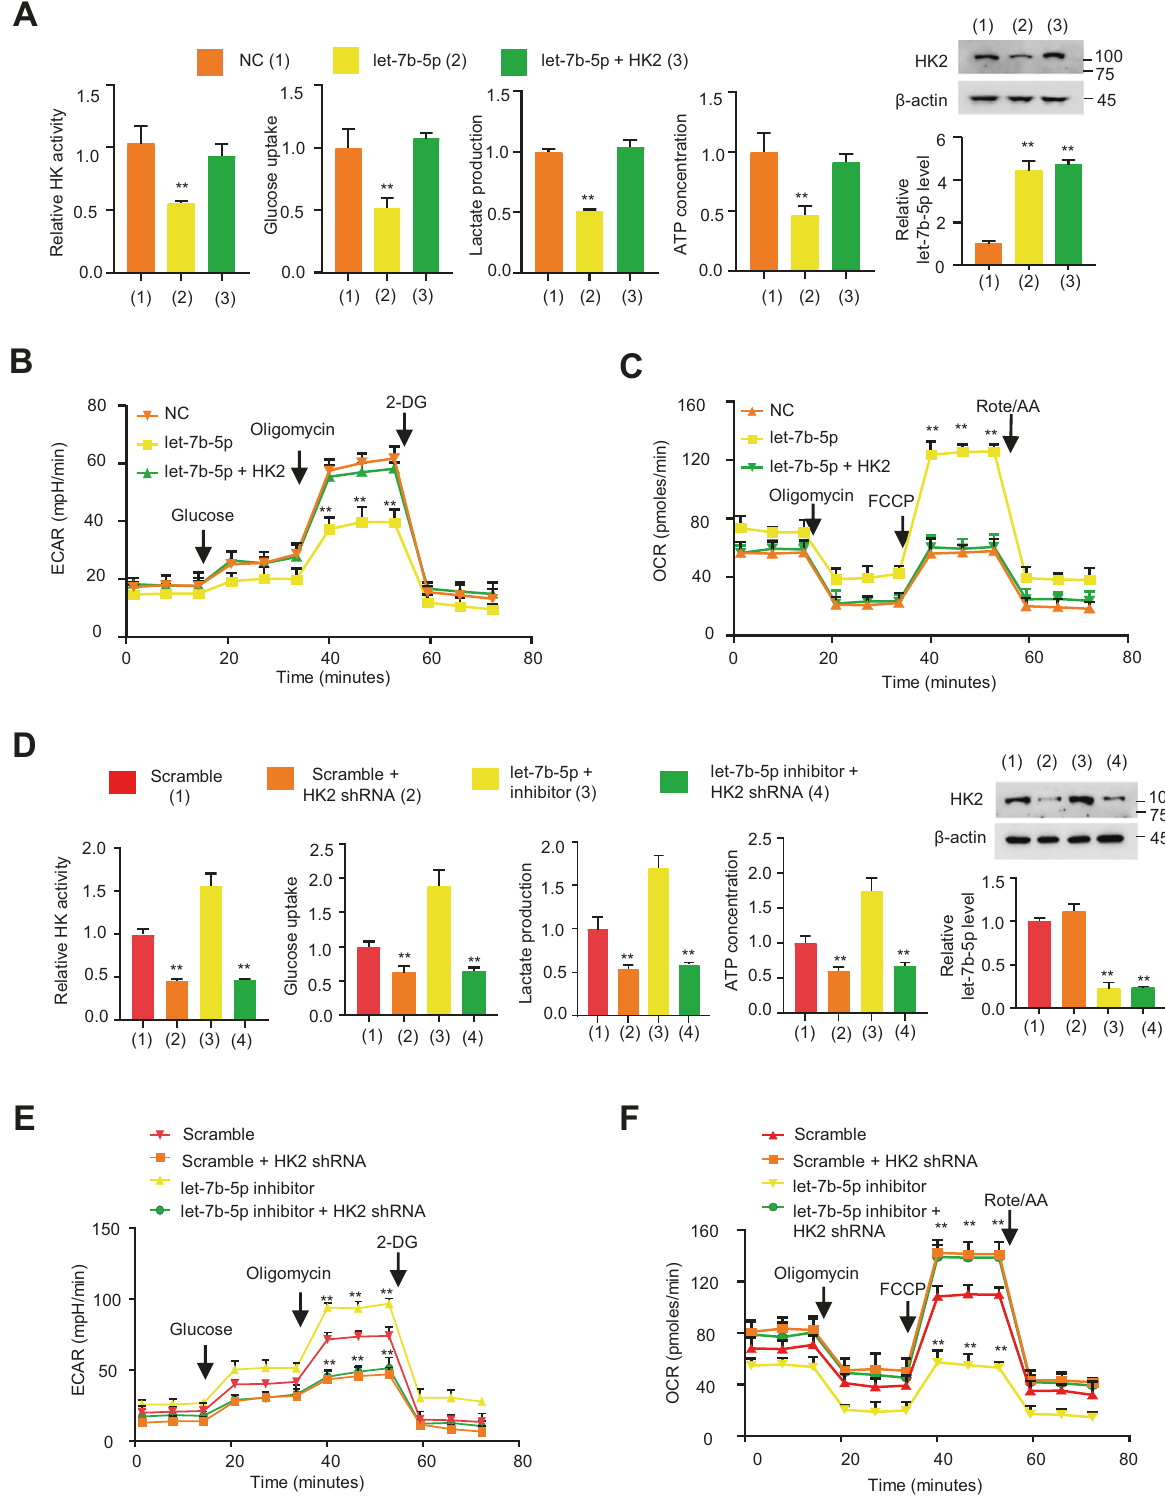
Fig. 4 Let-7b-5p impairs glycolysis by suppression of HK2 expression in BC cells. A HK activity, glucose uptake, lactate production, and ATP concentration assays of MDA-MB-231 cells after transfection with NC, let-7b-5p mimic or let-7b-5p mimic plus HK2 plasmid ( n = 3, mean ± SD). Western blot and RT-qPCR analysis reveal HK2 and let-7b-5p expression, respectively ( n = 3, mean ± SD). B , C ECAR ( B ) and OCR ( C ) were assayed after MDA-MB-231 cells were transfected as in ( A ) ( n = 4, mean ± SD). D Control or HK2 shRNA MDA-MB-231 cells with transfection of let-7b-5p inhibitor or scramble were detected as in ( A ) ( n = 3, mean ± SD). E , F ECAR ( E ) and OCR ( F ) detection of control or HK2 shRNA MDA- MB-231 cells after transfection as in ( D ) ( n = 4, mean ± SD). ** p < 0.01 versus corresponding